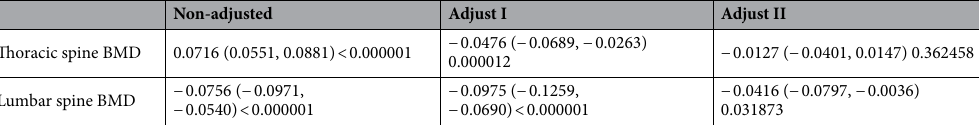
Table 2. Relationship between HGB and BMD. Expose variable HGB (g/dL), ending variable thoracic Spine BMD and lumbar spine BMD (mg/cm 2 ), the results in the table are expressed as β (95% CI). Model 1, no covariates were adjusted. Model 2, age, sex, race were adjusted. Model 3, age, sex, race, annual household income, education level, SBP, DBP, BMI, red blood cell count, albumin, ALP, ALT, blood urea nitrogen, total calcium, iron, CPK, creatinine, glucose, LDH, phosphorus, total bilirubin, total protein, uric acid, albumin creatinine ratio, blood cadmium, blood lead, phosphorus, potassium, triglyceride, LDL-C, HDL-C, total cholesterol, alcohol status, smoking status and diabetes were